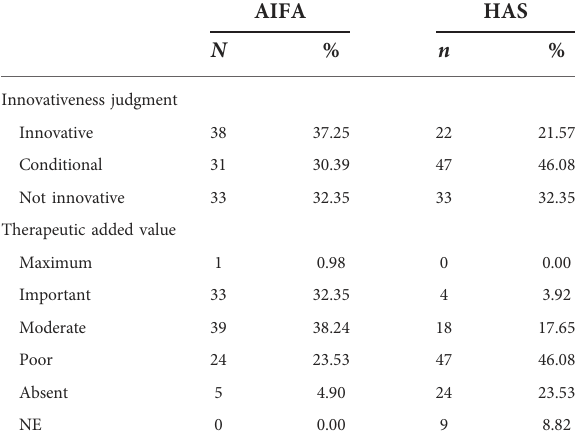
TABLE 5 Summary table on medical products included in the